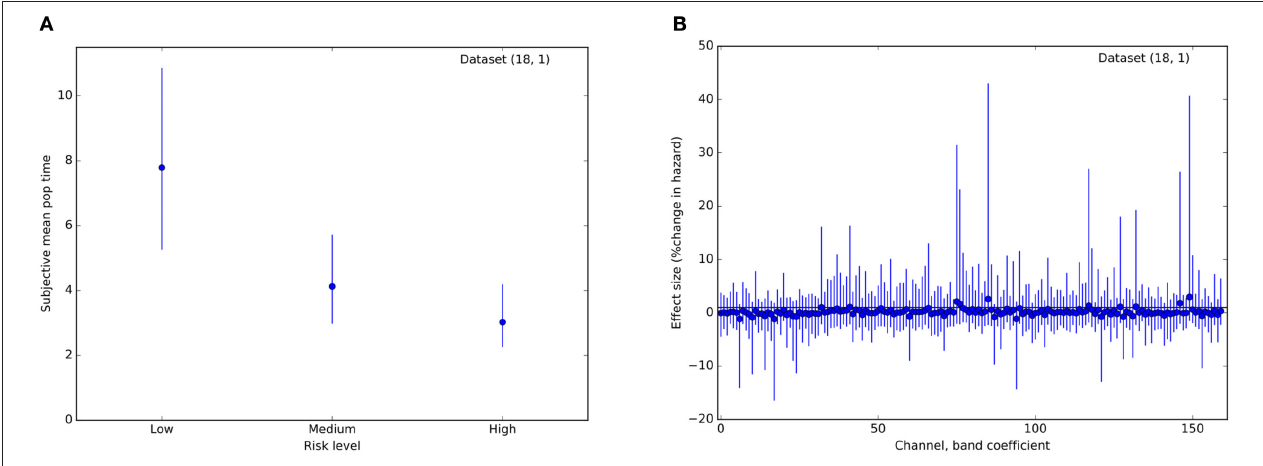
FIGURE 5 | Results from a Bayesian proportional hazards regression model. (A) Risk level (balloon color) modulates hazard rate. Plot of estimated mean parameter for a hazard function based on a normal distribution of event (stop) times. Dots indicate median of the posterior distribution, lines indicate 95% posterior credible intervals. (B) Posterior estimates of regression coefficients (one per frequency band, channel pair) for the model. Effect sizes are measured in percent change in hazard rate per standard deviation of the regressor (regressors were standardized to have variance 1). Conventions are as in (A) . For all coefficients, the 95% credible interval includes 0, indicating that local field power did not improve predictions of stop time. These plots are for a single representative dataset (18,